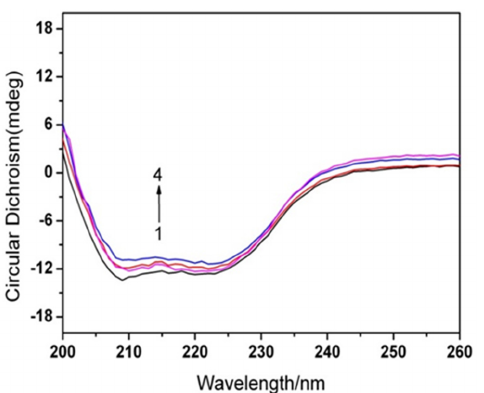
Figure 4. CD spectra of HSA in the absence and presence of AgNPs. The concentration of HSA is 1 × 10 − 6 M, the concentrations of AgNPs reach (1–4): 0, 1.5 × 10 − 11 M, 4.0 × 10 − 11 M, and 1.0 × 10 − 10 M, separately. 1.0 × 10 − 10 M, separately.